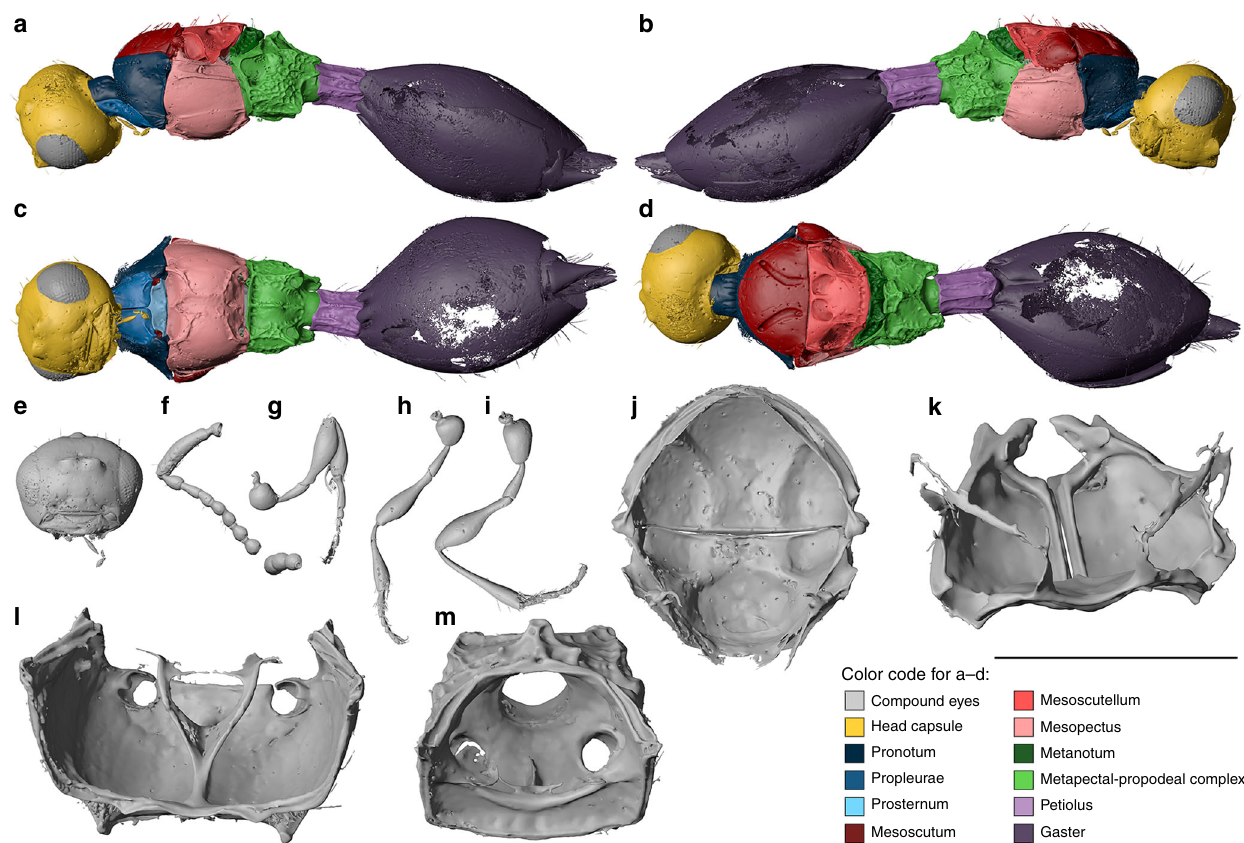
Fig. 7 Digital reconstruction of Palaeortona quercyensis gen. & sp. nov. (Diapriidae: Diapriinae: Psilini). Female holotype NMB F2770. Habitus ( a – d ), head ( e ), right antenna ( f ), right foreleg ( g ), right midleg ( h ), and right hind leg ( i ). Internal anatomical structures ( j – m ): mesonotum ventral view ( j ), propectus dorsolateral view ( k ), mesopectus anterior view ( l ), and metapectal-propodeal complex anterior view ( m ). Scale bar: a – i = 1 mm; j = 500 µ m; k = 250 µ m; l , m = 400 µ Wings: Not traceable. Legs: All legs with elongate simple trochanters. Protibial spur with distinct cleft. Midleg with two mesotibial spurs. Hind leg with two metatibial spurs.